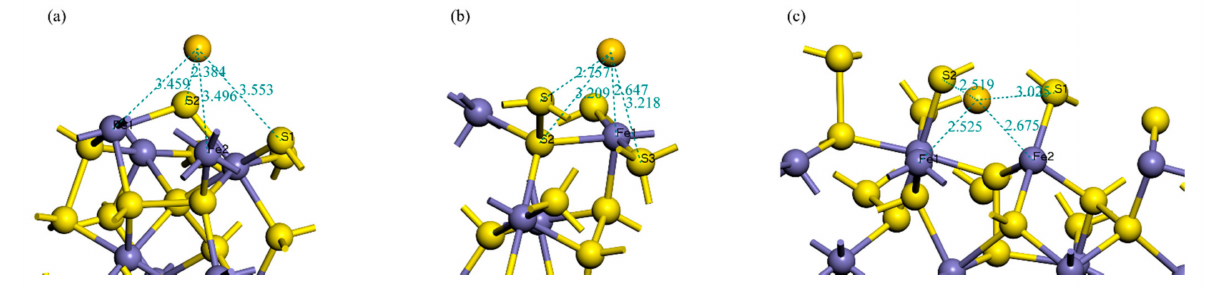
Figure 2. Geometry optimization model after adsorption of gold atoms on pyrite ( a ) (100), ( b ) (111), and ( c ) (210) surface. (The yellow ball: S; the blue ball: Fe; the gold ball: